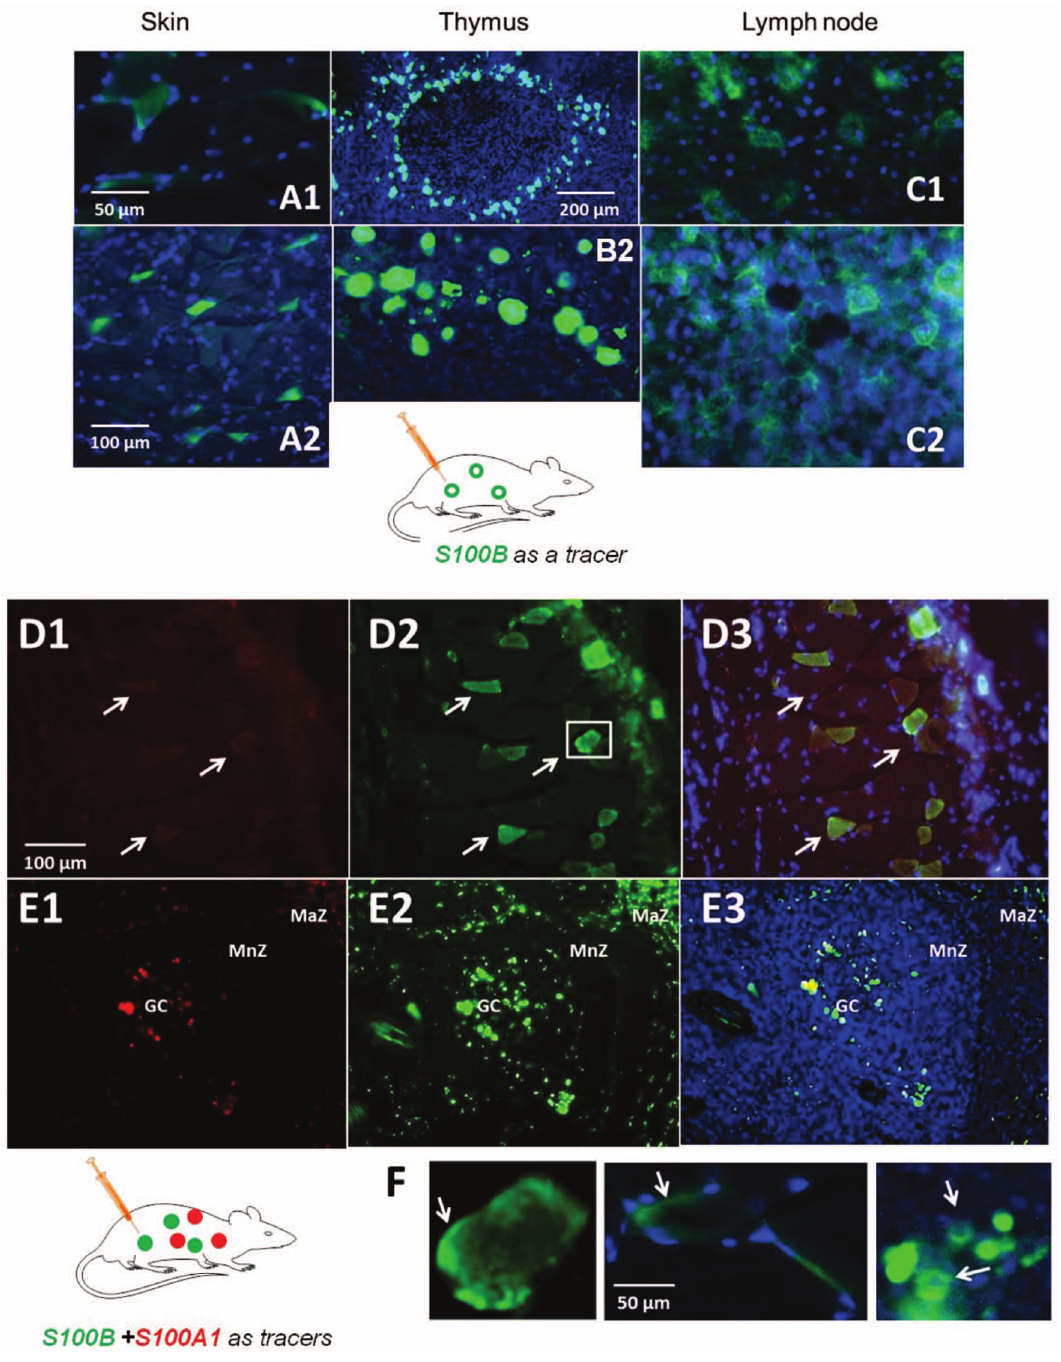
Figure 4. Circulating S100B is taken up by peripheral immune cells. AlexaFlour 488-tagged S100B protein accumulated in Langerhans cells of the skin ( A1, 2 ), thymic dendritic cells ( B1, 2 ), and in dendritic cells in lymph nodes (a para-aortic lymph node is shown in C1, 2 ). Note the lack of uptake by non-immune surrounding tissue. Also note the typical appearance of dendritic cells in nodal tissues. Injection consisted of AlexaFlour 488- tagged S100B at a concentration of 0.12 ng/mL introduced via tail vein and allowed to circulate 2–3 hrs. prior to tissue harvesting; DAPI ( blue ) was added as a nuclear stain. Note the different magnifications among the panels, with scale bar =200 m m in B1, 100 m m in A2 and 50 m m in all other panels. Rats were injected with a combination of AlexaFlour 594-tagged S100A1 ( red ) and AlexaFlour 488-tagged S100B ( green ). Skin ( D ) and splenic ( E ) tissue revealed that Langerhans cells ( arrows in D) and splenic cells within the germinal center ( GC ), mantel zone ( MnZ ) and marginal zone ( MaZ ) demonstrate uptake of both S100A1 and S100B; however, the extent and intensity of S100B uptake was much greater as also evident in the merged figures (D3, E3). F shows the preferential segregation of S100B at the membrane of dendritic cells in skin ( F1 and F2 ) and thymus ( F3 ); greater detail of a Langerhans cell from D2 (box) is shown in F1 in order to highlight membrane staining. Injection consisted of AlexaFlour 488-tagged S100B at a concentration of 0.10–0.12 ng/mL introduced via tail vein and allowed to circulate 2–3 hrs. prior to tissue harvesting; DAPI (blue) was added as a nuclear stain. GC = germinal center, MnZ = mantle zone, MaZ = marginal zone .